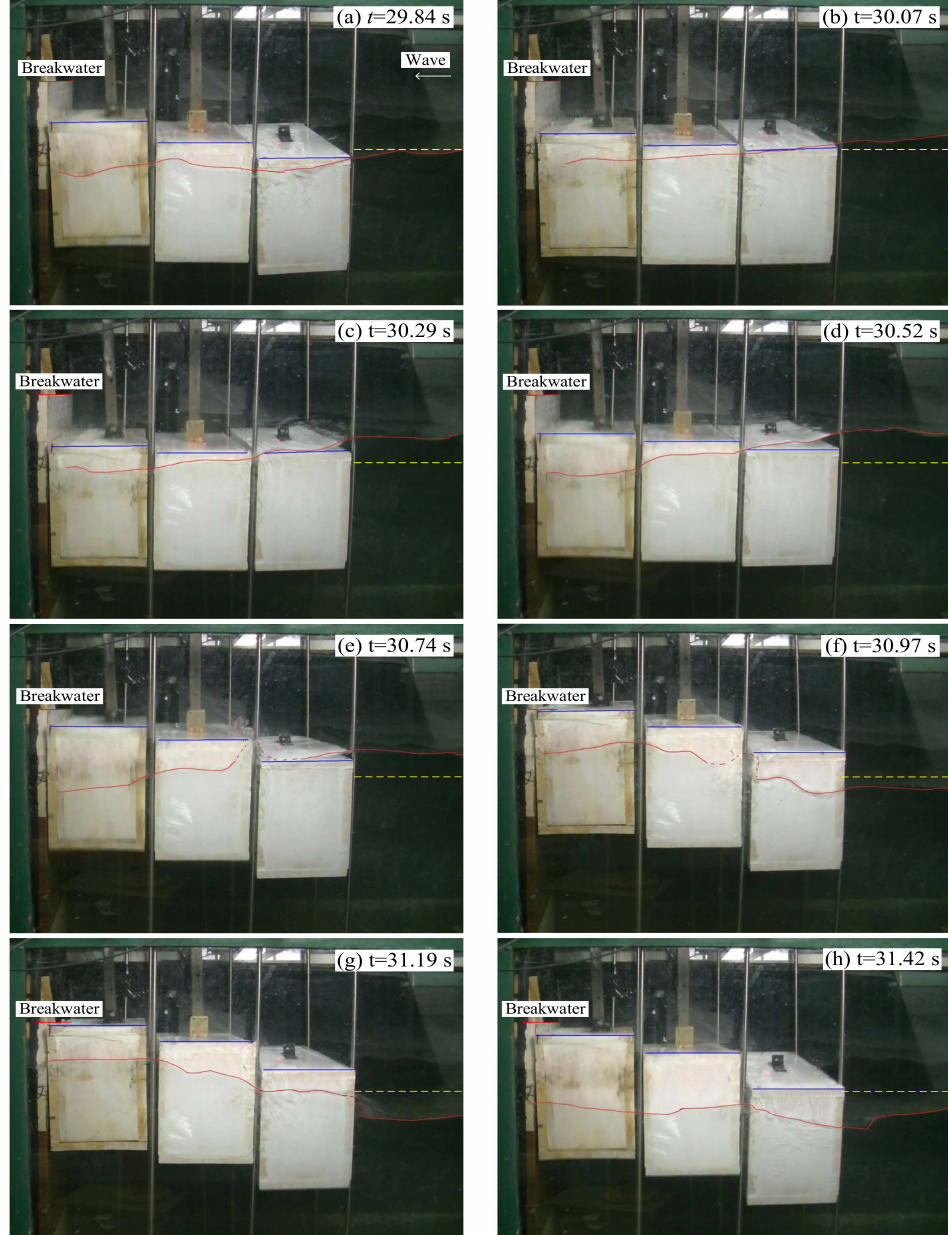
Figure 11. Snapshots of the wave–structure interactions during experiments. ( T i = 1.8 s, h = 0.6 m, H i / L i = 0.03): ( a ) t = 29.84 s; ( b ) t = 30.07 s; ( c ) t = 30.29 s; ( d ) t = 30.52 s; ( e ) t = 30.74 s; ( f ) t = 30.97 s; ( g ) t = 31.19 s; ( h ) t = 31.42